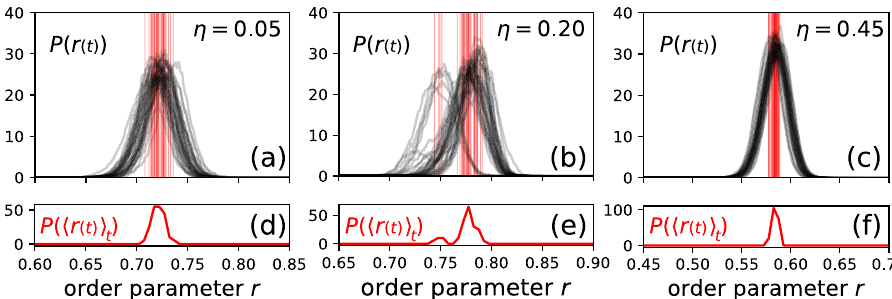
Fig. 2 Dynamical noise vs quenched disorder. Panels a – c : Black curves correspond to probability density functions of polar order r ( t ) obtained from stationary regime of 40 simulations with Voronoi interaction and different obstacle con fi gurations, at obstacle density ρ o = 0.15 and noise intensity η = 0.05, 0.20, and 0.45 from left to right respectively. Red vertical lines correspond to the mean (time-averaged) polarization of each of the 40 distributions. Panels d – f : Probability density function of the mean polarization values.